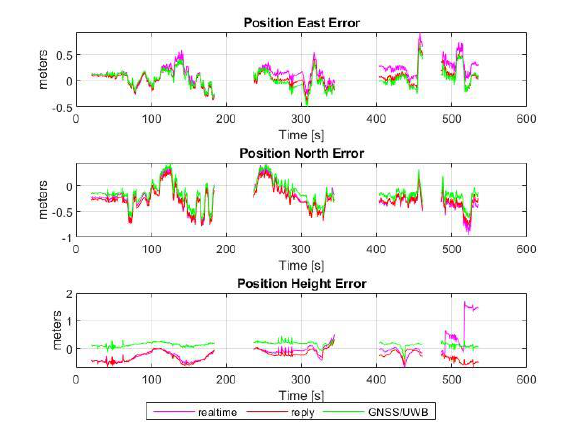
Figure 11. Positioning estimation errors of the three reference system components for real-time, replay and GNSS/UWB